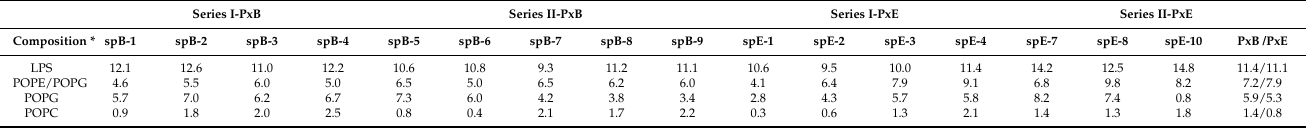
Table 2. Increase in surface pressure ( ∆ π /mN · m − 1 ) upon penetration of the antimicrobial lipopeptides into monolayers ** at an initial pressure of 32 mN · m − 1 .